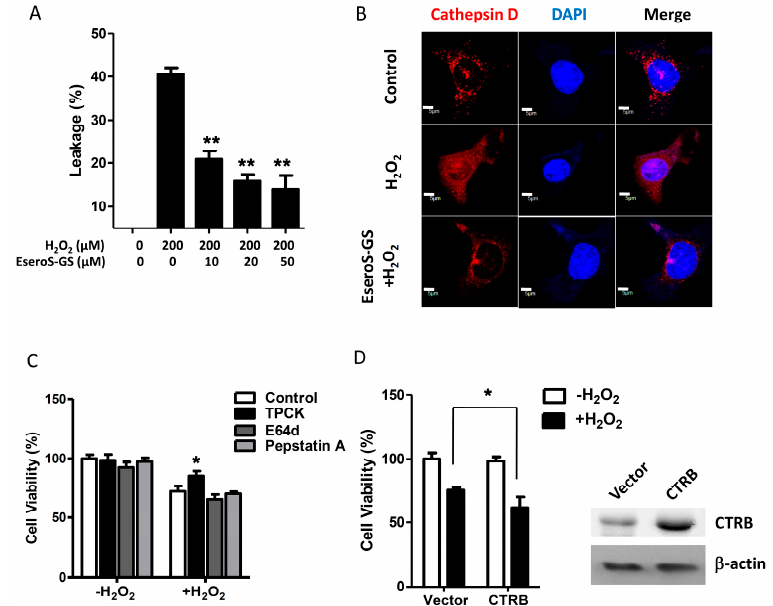
Figure 3. ESeroS-GS inhibits oxidative stress-induced lysosome membrane permeabilization and blocks the relocation of lysosomal chymotrypsin in SH-SY5Y neuroblastoma cells. ( A ) ESeroS-GS inhibits oxidative stress-induced lysosome membrane permeabilization; ( B ) ESeroS-GS blocks the relocation of lysosomal protease. Scale bar: 5 µ m; ( C ) inhibition of chymotrypsin prevents oxidative stress-induced cell death; ( D ) Overexpression of chymotrypsin potentiates oxidative stress-induced cell death. The efficacy of chymotrypsin overexpression was evaluated by immunoblot analysis. Transfection with chymotrypsin B (CTRB) vector resulted in a marked (~5 times) increase in cellular chymotrypsin levels in SH-SY5Y neuroblastoma cells. *: p < 0.05; **: p < 0.01.